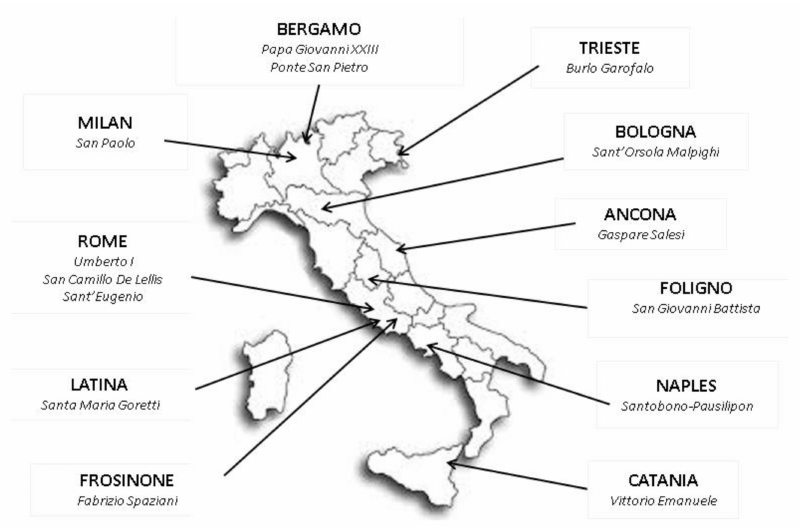
Figure 1. Pediatric Emergency Rooms (ERs) included in the